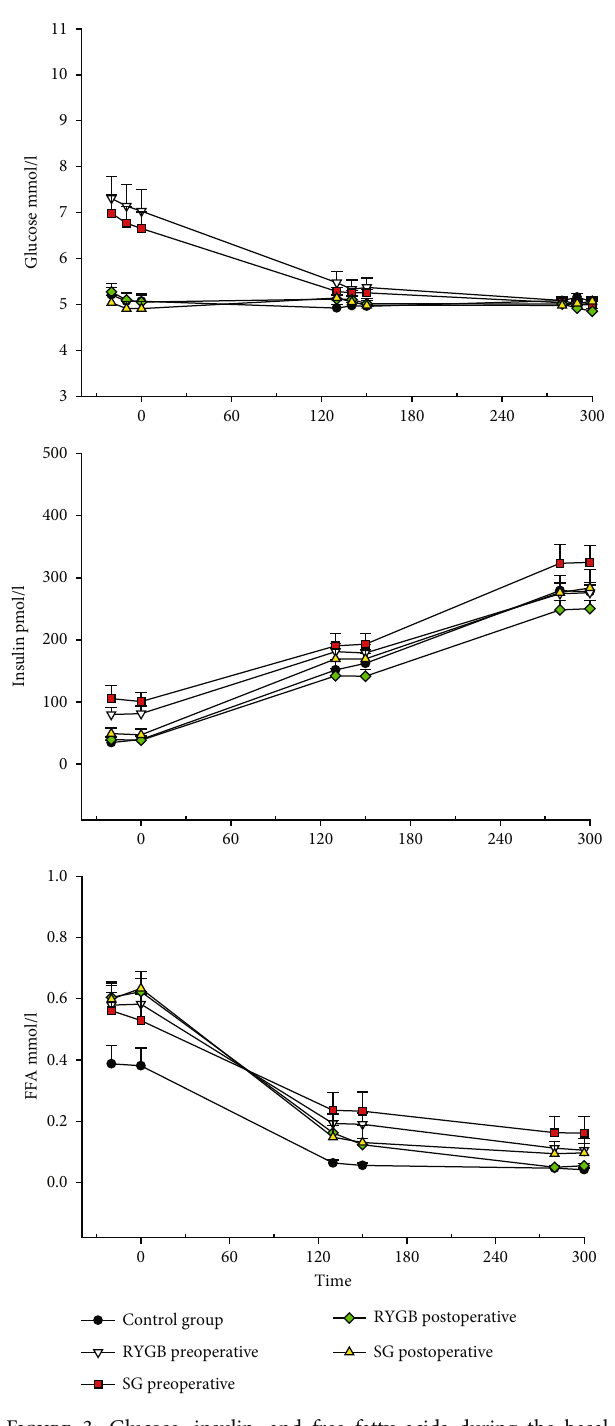
Figure 3: Glucose, insulin, and free fatty acids during the basal period and two-step hyperinsulinemic euglycemic clamp. Displayed as the mean with the standard error of the mean. p values < 0.05 are considered statistical signi fi cant. ∗ Signi fi cant di ff erence from the control group. ∗∗ Signi fi cant di ff erence between post- and preoperative values within each group. ∗∗∗ Signi fi cant di ff erence between RYGB and SG. Abbreviations: FFA: free fatty